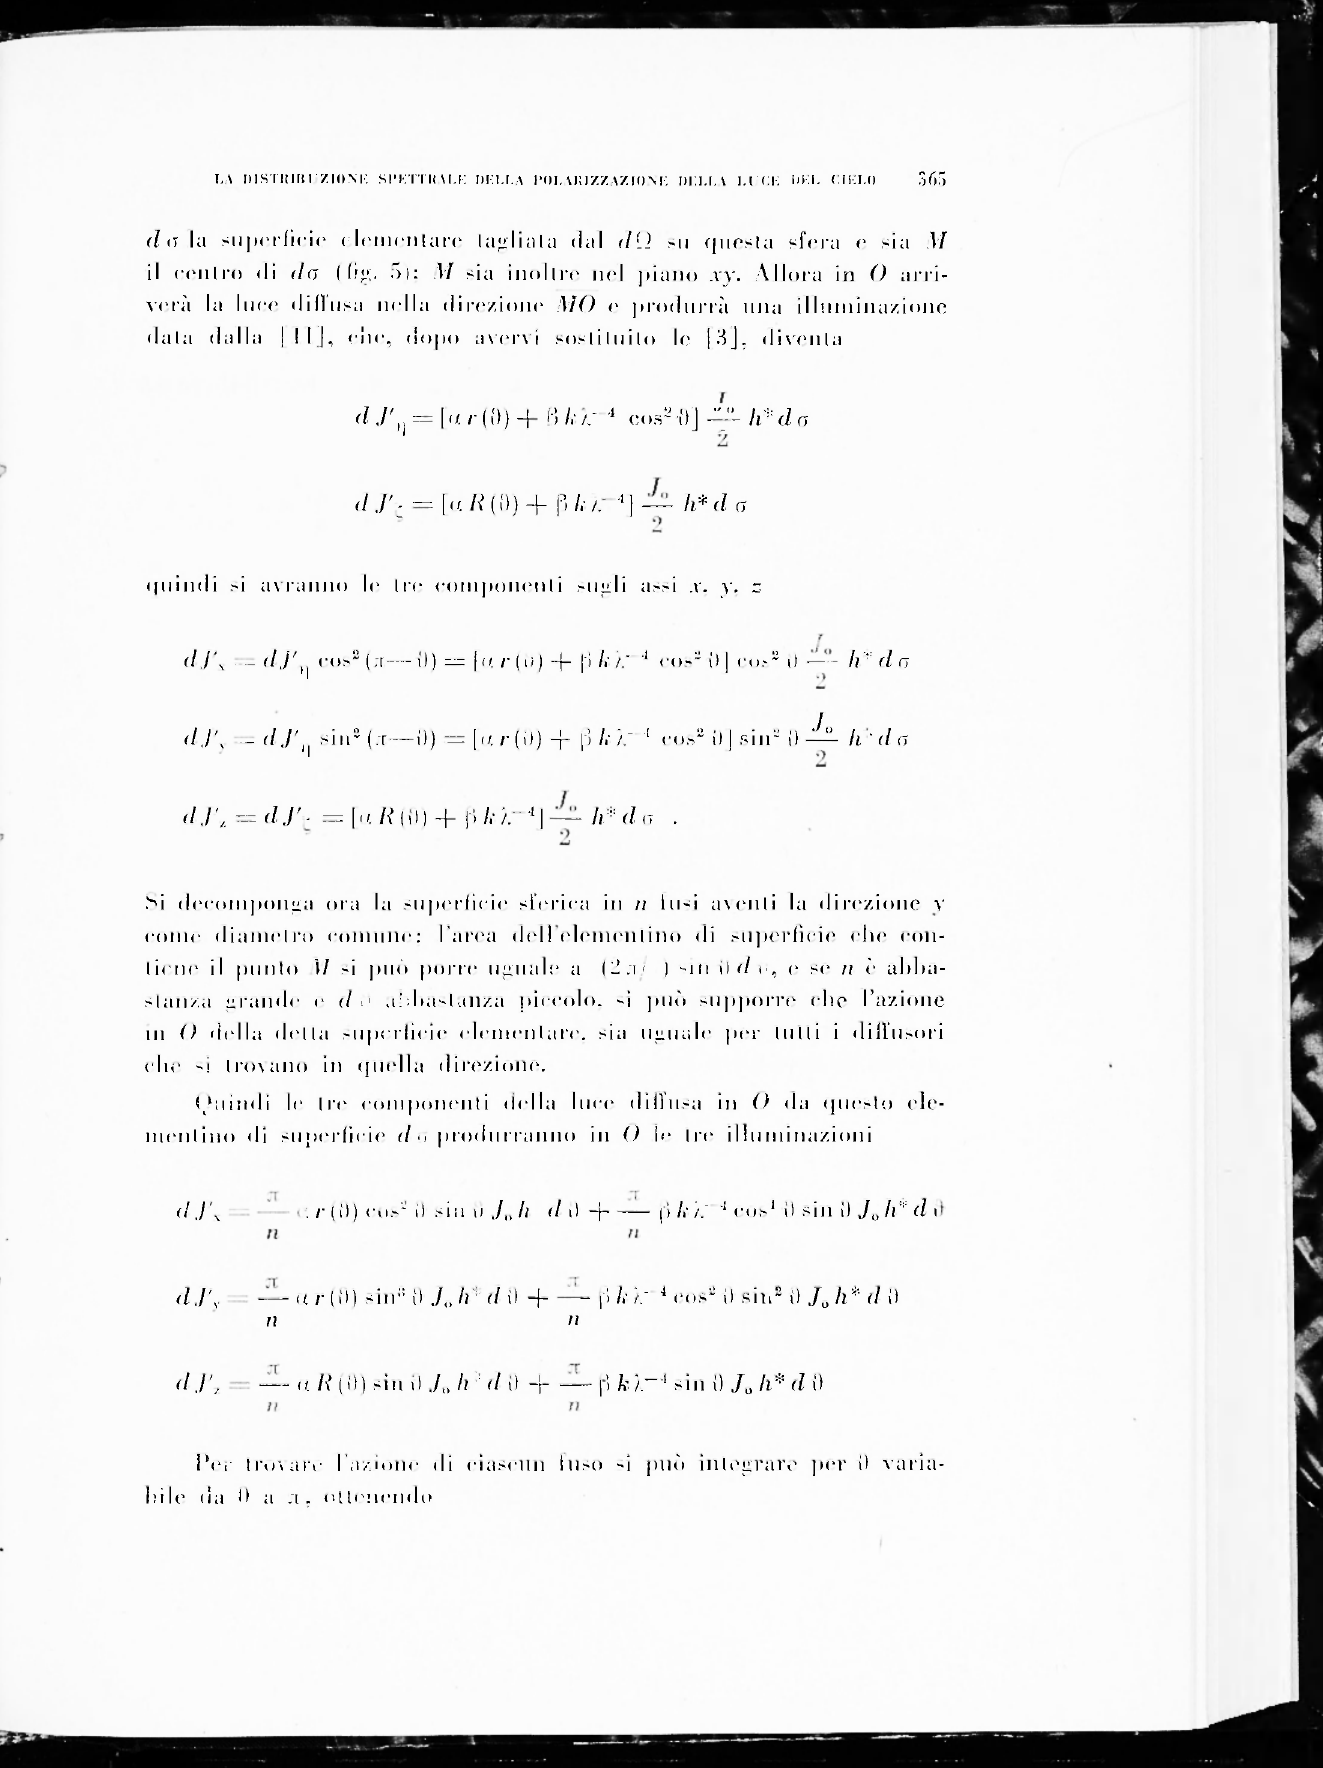
(fig. Si; M sia inoltre nel piano xy. Allora in O